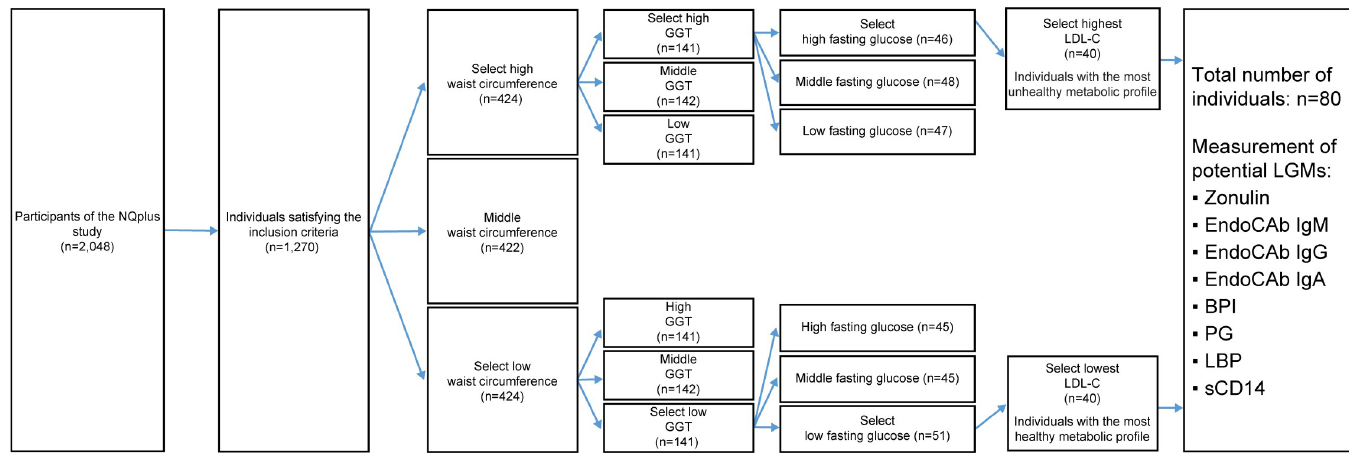
Fig 1. Schematic overview of subject selection from the NQplus study. Following this scheme, 40 individuals with the most healthy metabolic profiles and 40 individuals with the most unhealthy metabolic profiles from the NQplus study were selected.